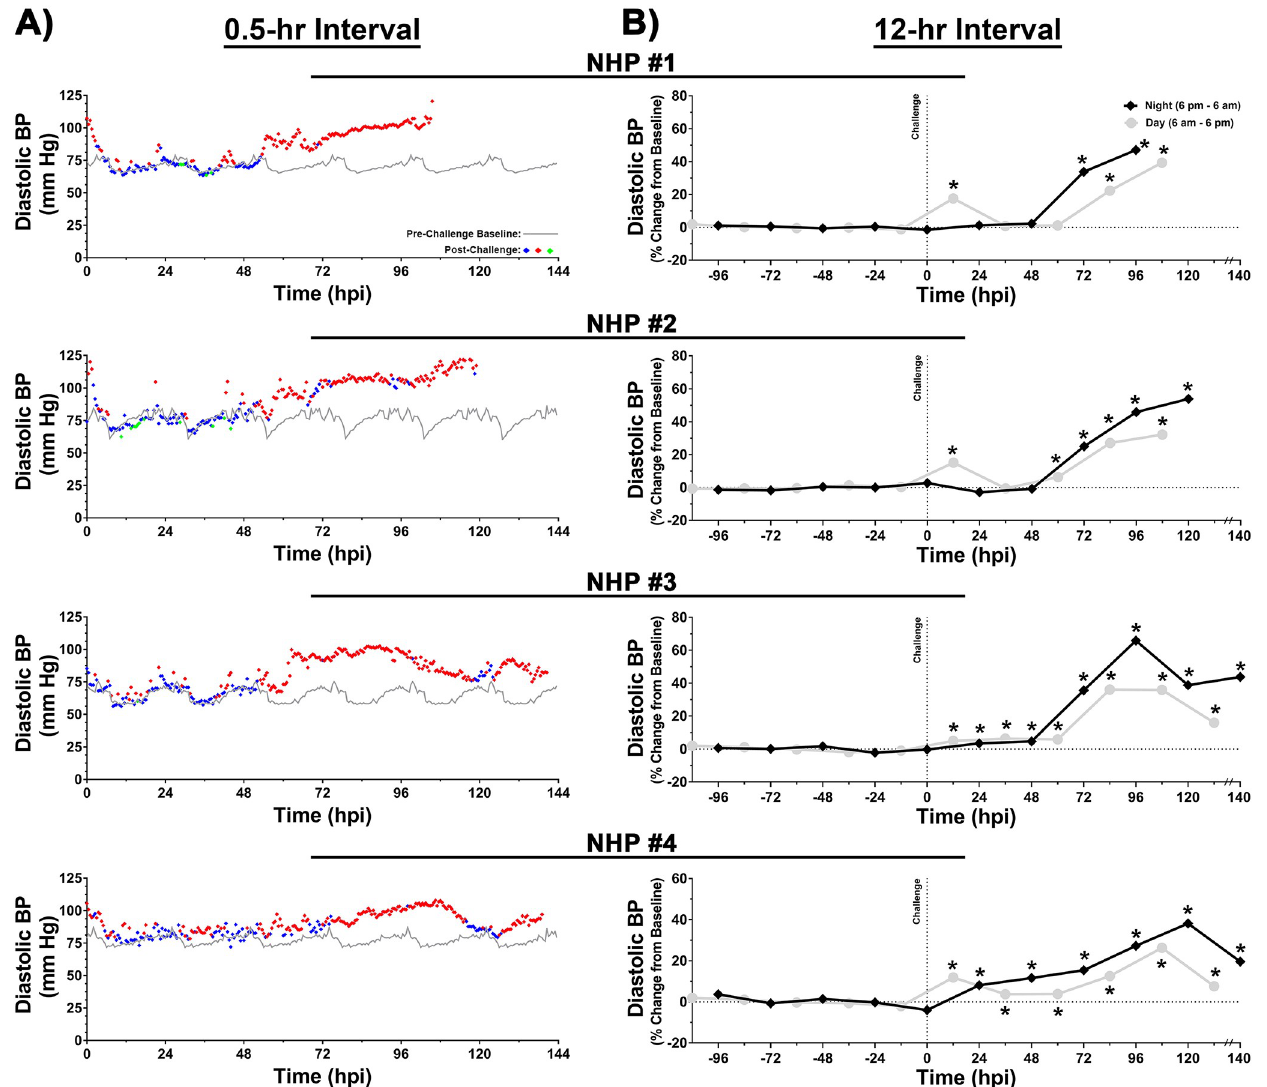
Fig 9. Diastolic blood pressure of NHPs pre- and post-EEEV challenge. Data analysis is shown in 0.5- (A) and 12-hr (B) daytime/nighttime intervals. All NHPs were continuously monitored pre- and post-challenge. Pre-challenge baseline diastolic blood pressure was measured for five day/night cycles and a 0.5-hr interval baseline average was calculated by averaging raw data of five time-matched day or night time intervals. Forty-eight 0.5-hr interval averages were used to construct a baseline diastolic blood pressure for a day/night cycle and is shown as a grey line (A). Post-challenge values within � 3 standard deviations (SD) are indicated with ( ), > 3 SD above baseline are indicated with ( ), and > 3 SD below baseline are indicated with ( ). Percent change from baseline in 12-hr interval is shown in grey (daytime) and in black (nighttime) (B). All raw data from either 12-hr daytime or nighttime intervals were averaged and normalized. The last data point for NHP #3 and 4 is an average of 8 hrs (B). p -values � 0.023 are indicated with � .